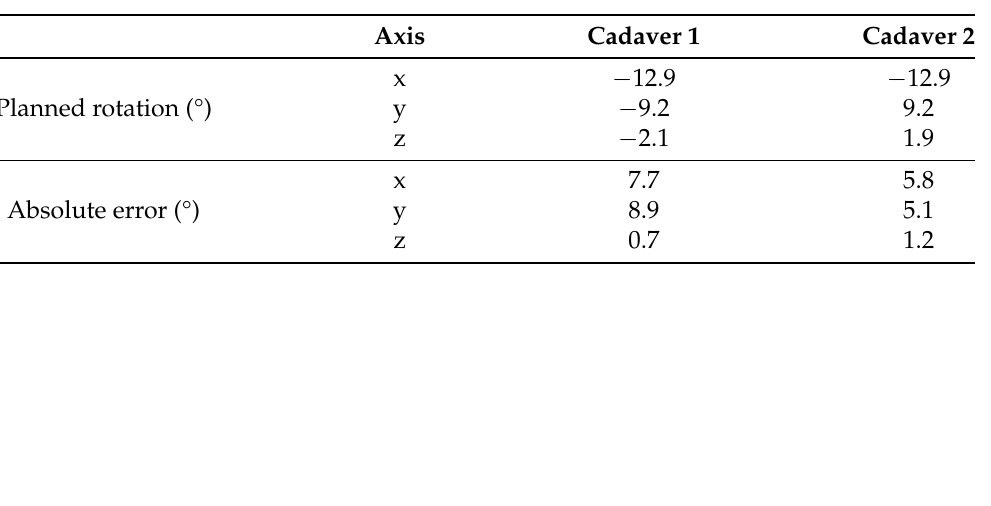
Table 2. 3D results of the AR guided fragment